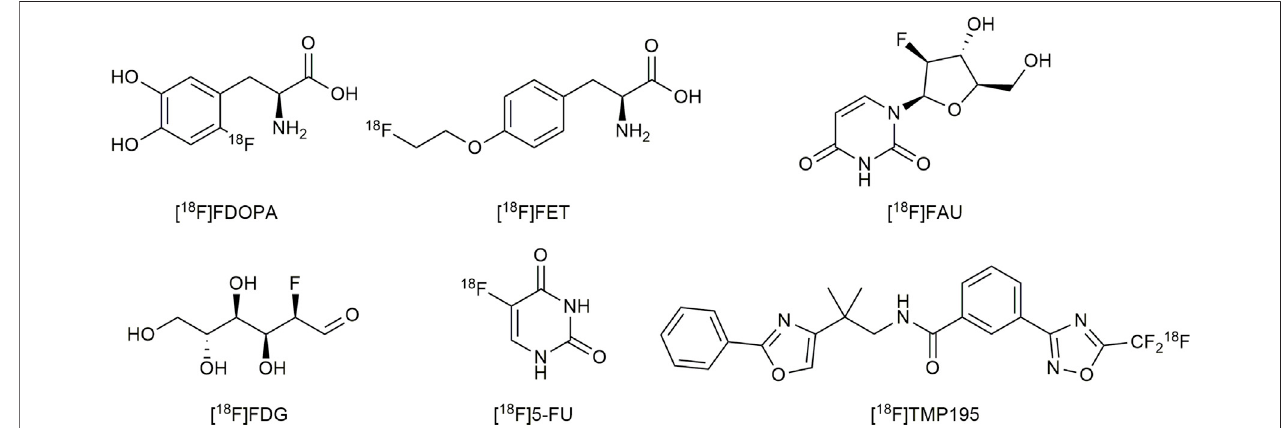
FIGURE 1 | Some examples of [ 18 F]-labelled PET tracers. RCC, radiochemical conversion; EDG, electron-donating group; DG, directing